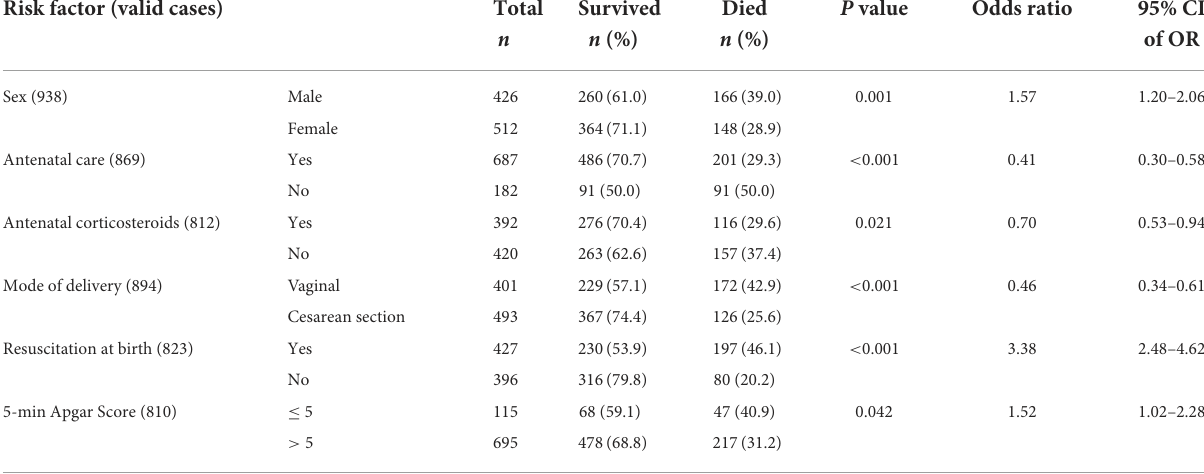
TABLE 1 Obstetric risk factors, infant characteristics and prediction of mortality.